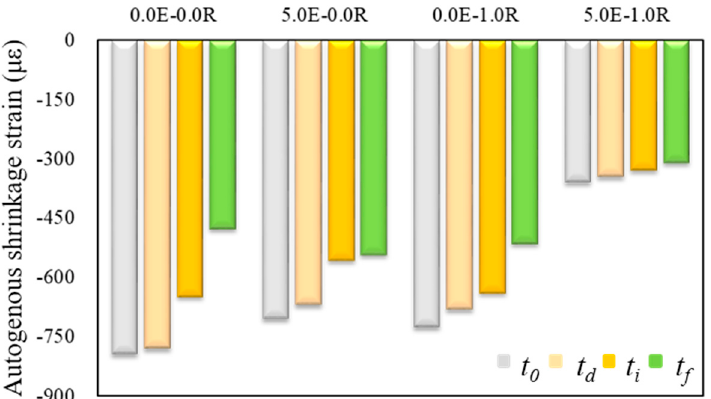
Figure 5. Comparison of 40 day autogenous shrinkage strain evaluated from different start point (start point of shrinkage strain development ( t 0 ), deviation point of shrinkage strain and temperature ( t d ), initial setting time ( t i ), and final setting time ( t f )).